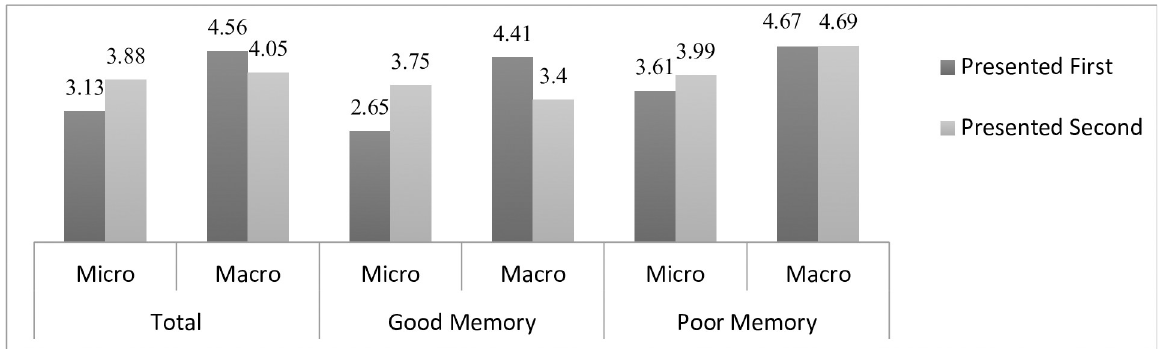
Fig 1. Micro and macro-level bias by order of presentation. Significant results: 1) Total first-order macro bias > Total first-order micro bias (p < .001). 2) Total second -order micro bias > Total first -order micro bias (p < .017). 3) Poor memory first-order micro bias > Good memory first-order micro bias (p = .044). 4) Good memory second -order micro bias > Good memory first -order micro bias (p = .01).